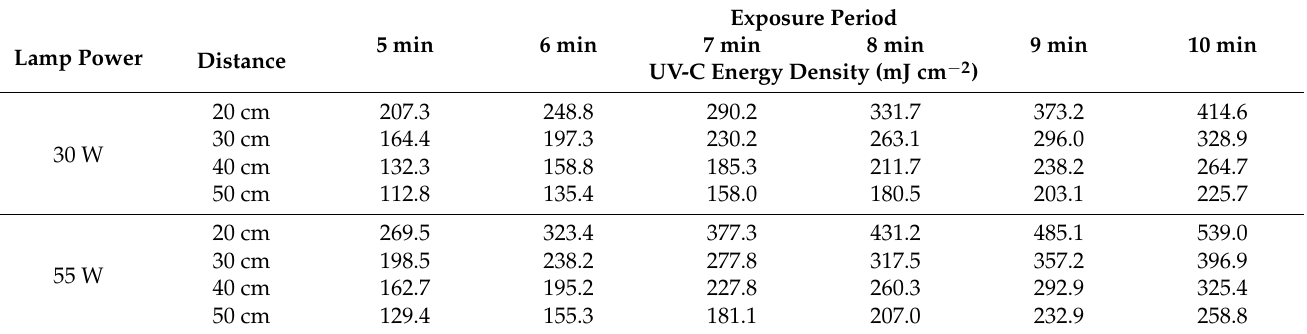
Figure 2. Microscopy images of the ( a ) inner and ( b ) outer layer of an FFP2 respirator. Table 1. UV-C energy density according to different exposure periods and distances between the lamp and the sample for the UV-C lamps of 30 W and 55 W in a laminar flow cabinet.